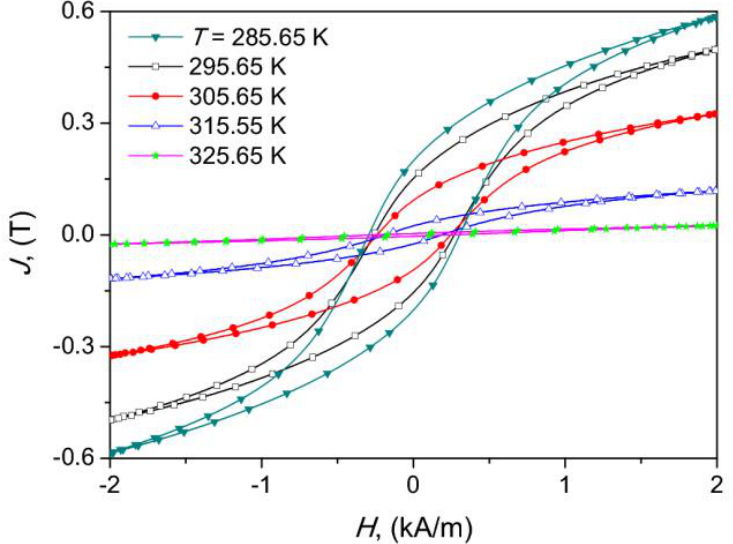
Figure 7. The effect of temperature on the shape of minor hysteresis loops for the composite core, H m H m = 2 kA / = 2 kA/m.